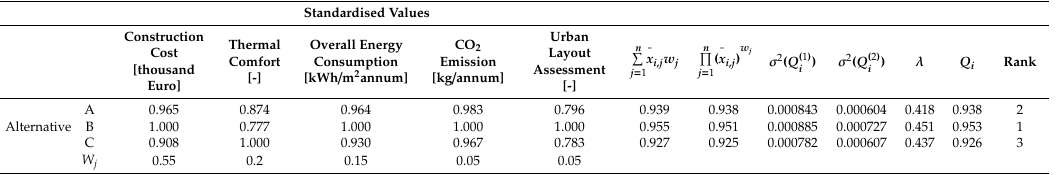
Table 13. Results of the multi-criteria analysis using the WASPAS method.